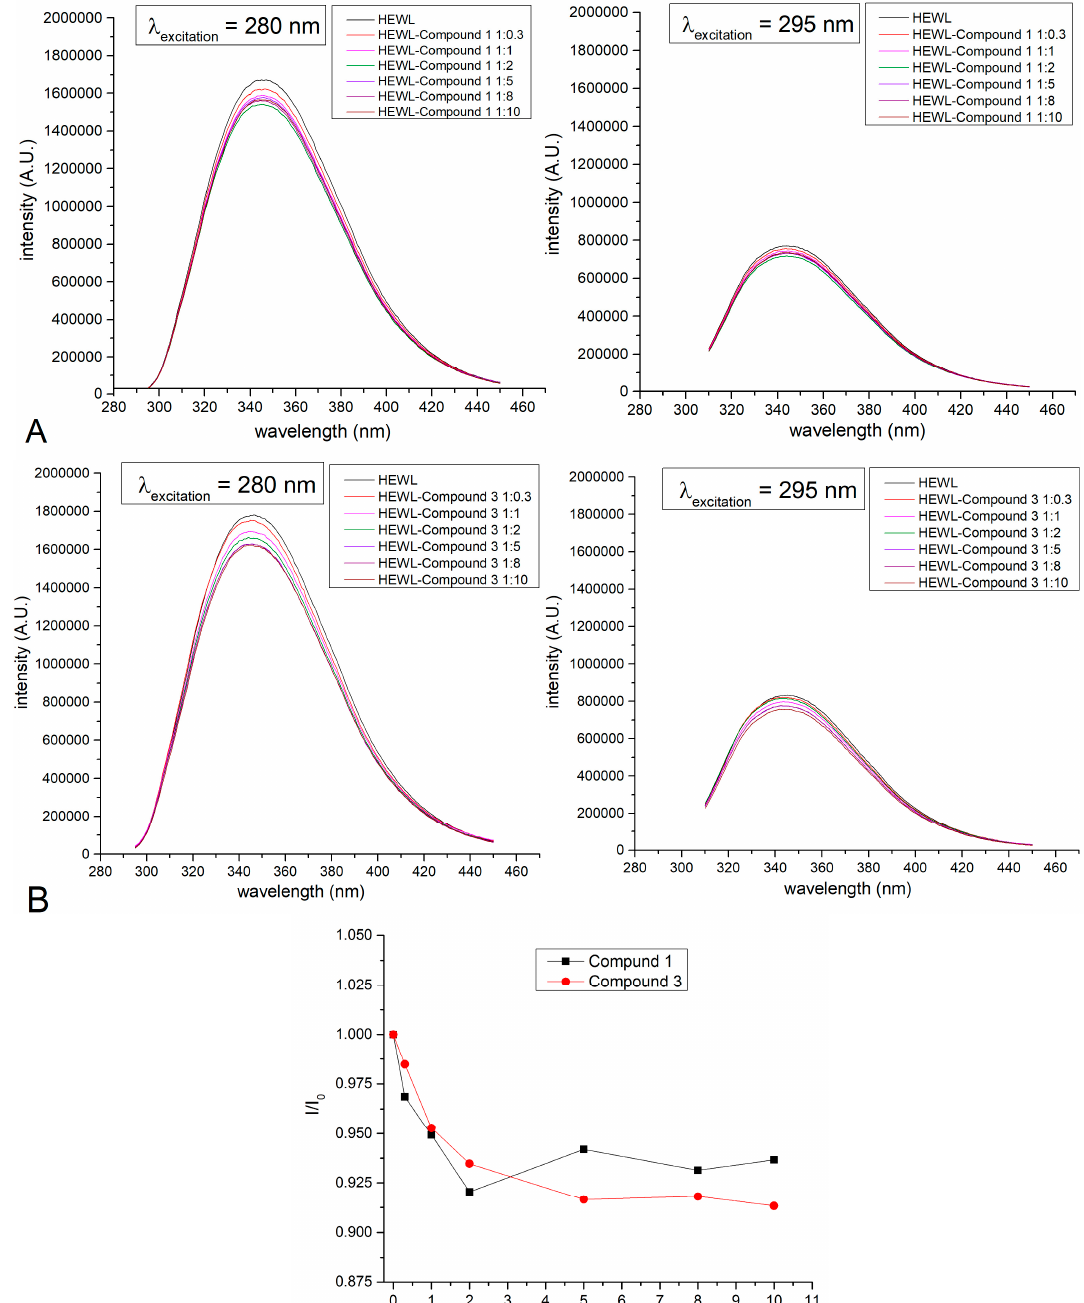
Figure 8. Fluorescence spectra of hen egg white lysozyme (HEWL) adducts with compounds 1 and 3 (0.05 mg/mL in 10% ethanol), prepared by mixing the protein with increasing concentrations of assayed compounds. ( A ) spectra of HEWL and 1 ; ( B ) spectra of HEWL and 3 ; ( C ) I / I o as a function of protein to compound ratio. Spectra were collected upon excitation at 280 nm (left panel) and 295 nm (right panel).